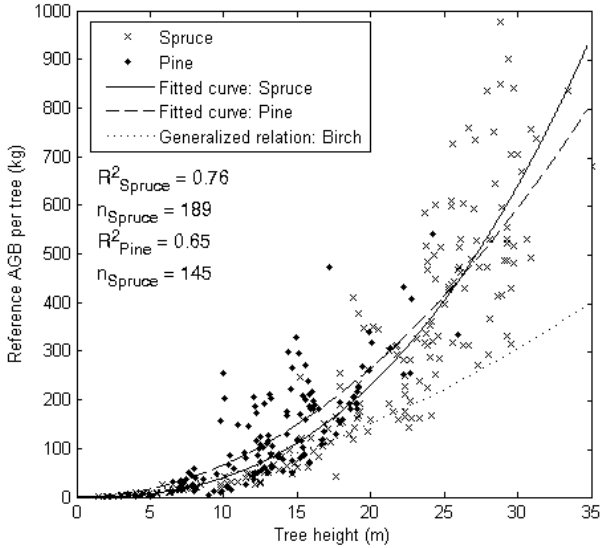
Figure 4. Power model for AGB prediction from LiDAR-derived height estimates for spruce and pine